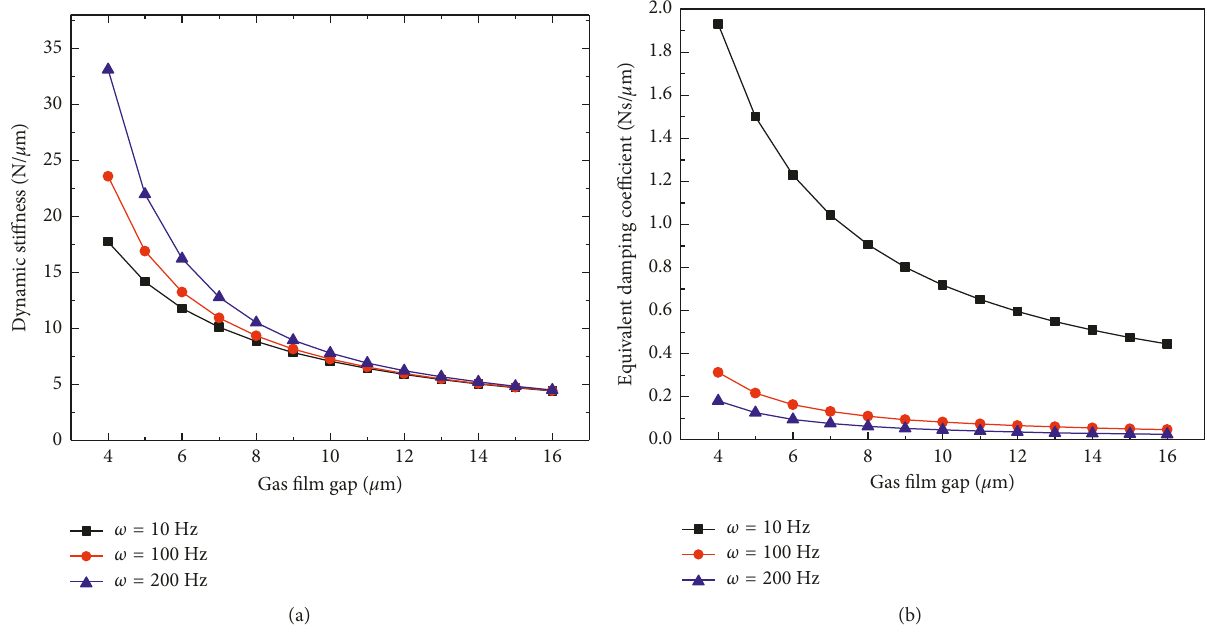
Figure 5: Influence of the gas film gap on dynamic characteristics of aerostatic bearings with EEPG. (a) Influence of the gas film gap on dynamic stiffness. (b) Influence of the gas film gap on the equivalent damping